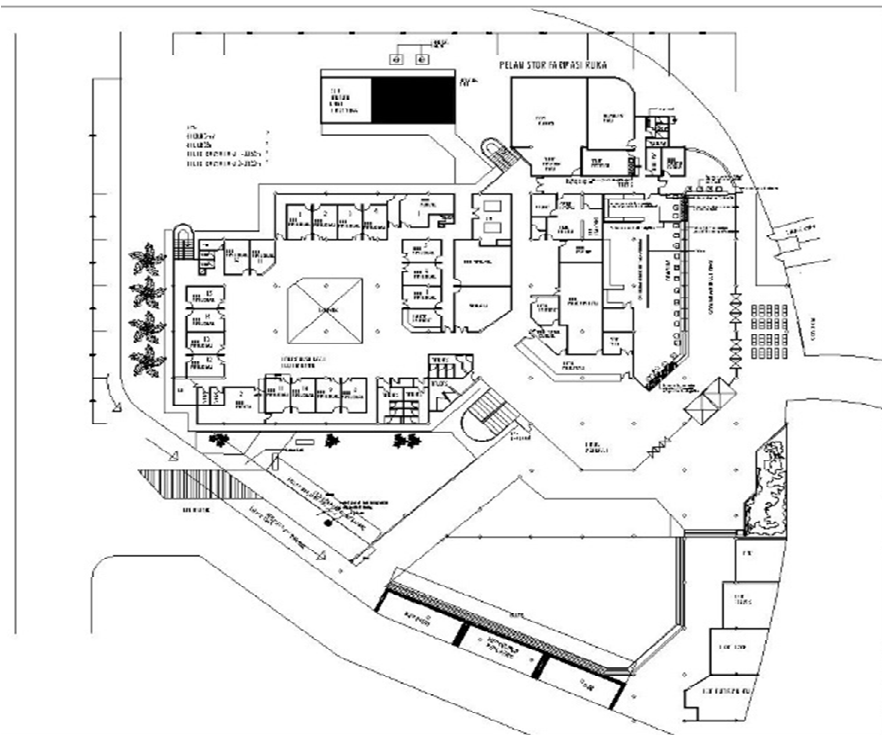
Figure 3. The layout of the ground floor of the RUKA building at the UMMC.